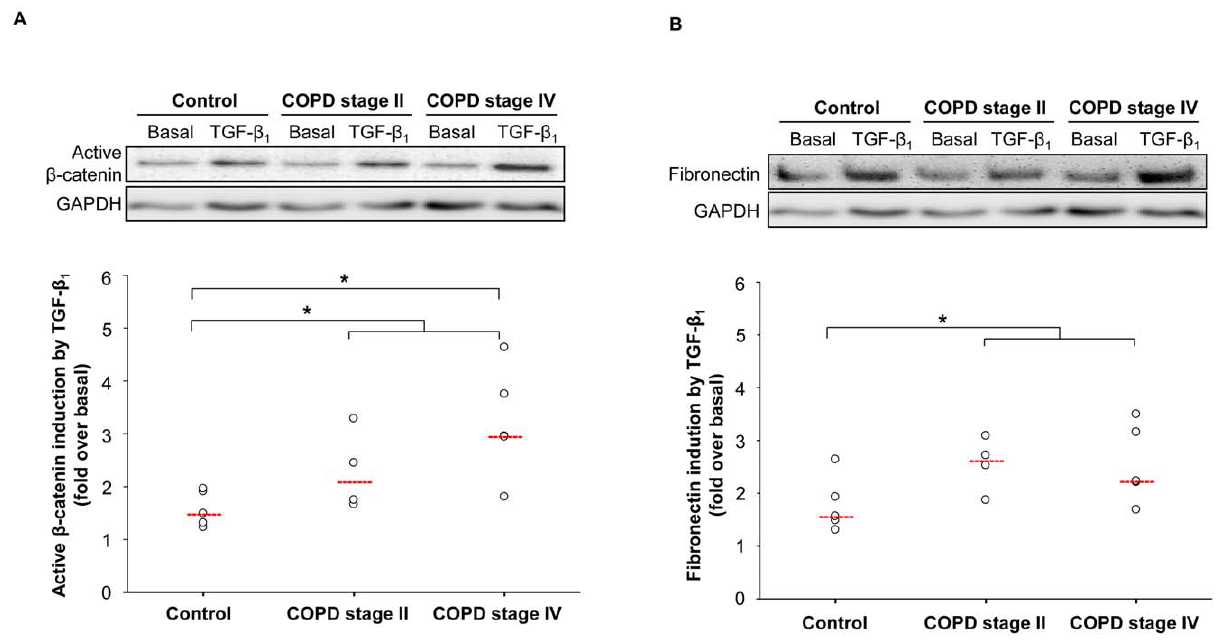
Figure 7. Increased b -catenin activation and fibronectin deposition in fibroblast of individuals with COPD in response to TGF- b 1 . Primary lung fibroblasts were isolated from individuals without (control) and with COPD (GOLD stage II and IV) as described in the materials en methods. The fibroblasts were grown to confluence and treated for 48 h with TGF- b 1 (2 ng/ml). Expression of active b -catenin (A) and fibronectin (B) was evaluated by immunoblotting. Equal protein loading was verified by the analysis of GAPDH. Responses were quantified by densitometry and normalized to the expression of GAPDH. Data are derived from 5 controls and 9 COPD patients (4 GOLD stage II and 5 GOLD stage IV). Median of each group is indicated by -----. *P , 0.05. Statistical differences between control and COPD were determined a two-tailed Mann-whitney test.